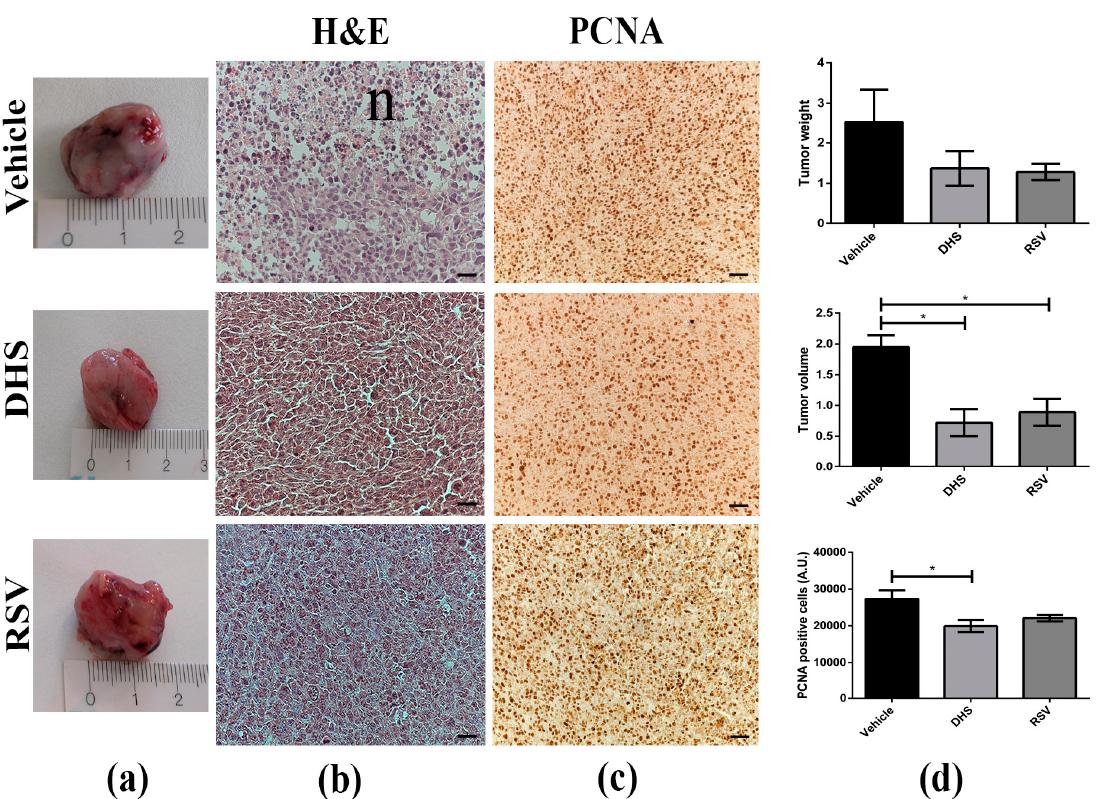
Figure 1. ( a ) Representative macroscopic view of LLC primary tumours in control (vehicle, 6 mice) and 4 weeks DHS- and RSV-treated mice (9 and 5 animals, respectively). ( b ) H&E staining of tumour masses (scale bars = 20 μ m; 40× magnification, n = necrosis). ( c ) Representative images obtained after PCNA immunostaining of the same tumour masses (scale bars = 40 μ m; 20× magnification). ( d ) Quantitative analysis of tumour weight, tumour volume, and PCNA positive cells. (n > 5; * p < 0.05).